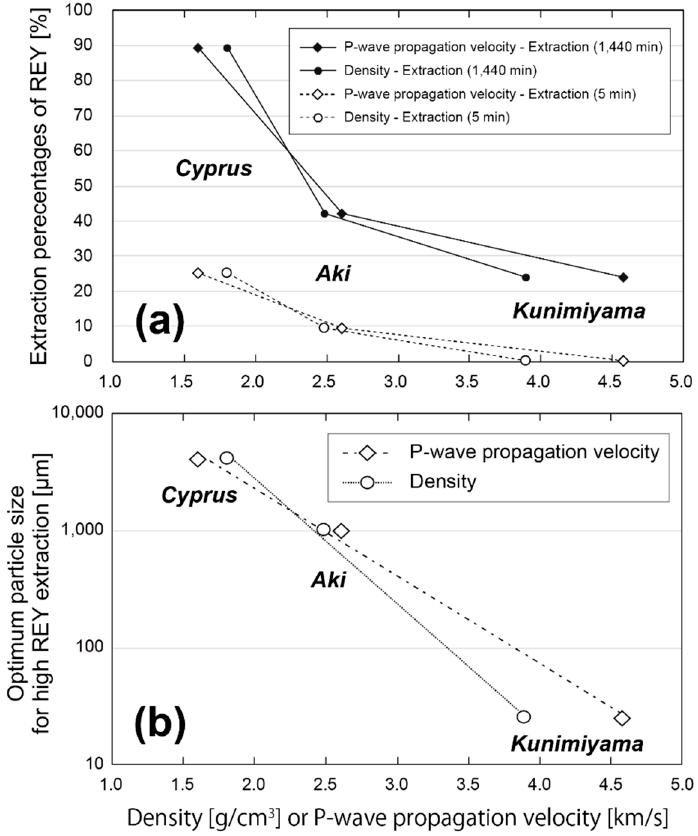
Figure 9. Effect of physical properties (density and P-wave propagation velocity) of the umber samples on the ( a ) extraction percentages of REY and ( b ) optimum particle size for high REY extraction.